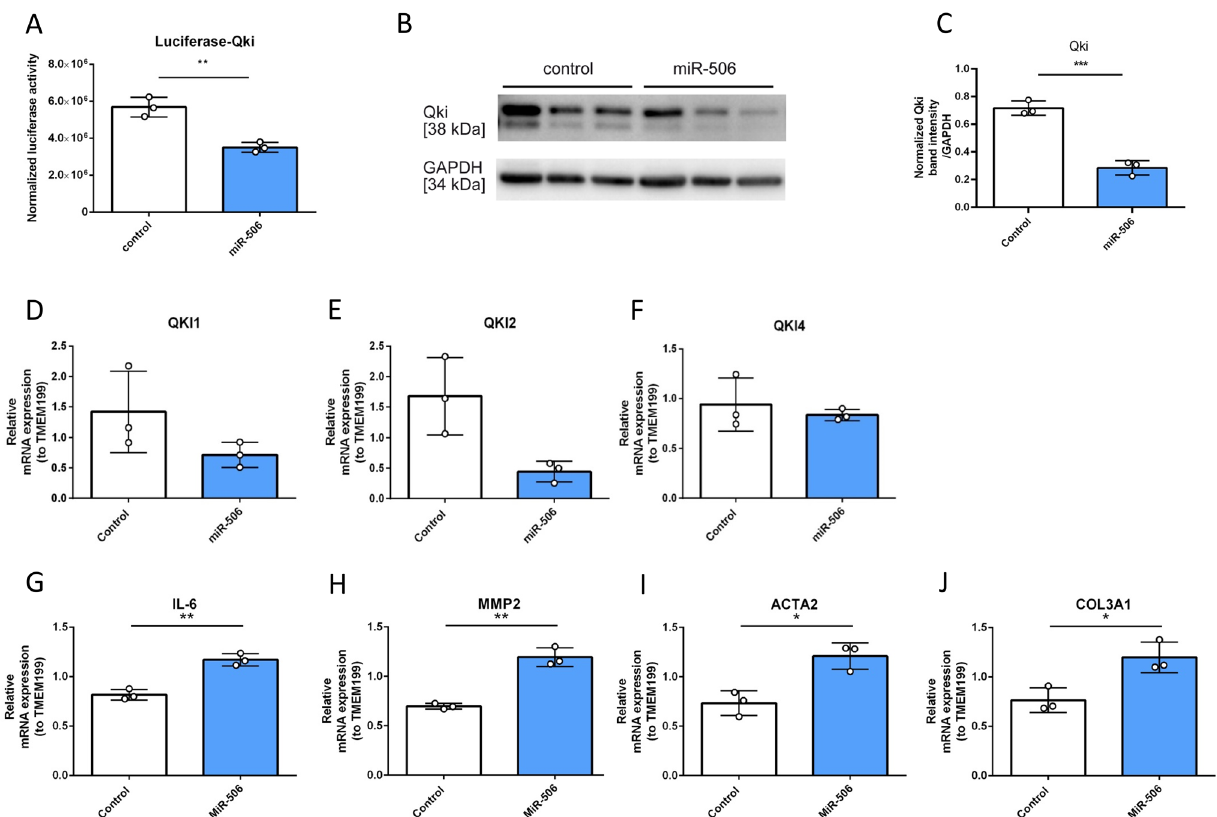
Figure 3. ( A ) Validation of miR-506-3p binding to human QKI 3 ′ -UTR via luciferase assay. (n = 3 experiments). ( B , C ) QKI is downregulated via miR-506 in human lung fibroblasts after 48 h of miR transfection. QKI (exposure 145.708 s) and GAPDH (exposure 36.664 s) detection via Western Blot after 48 h of overexpression (representative Western Blot) in vitro and statistical evaluation. (n = 3 experiments). Gene expression levels of ( D – F ) various QKI mRNA variants and ( G – J ) factors relevant for fibrosis (RT-qPCR) (*p < 0.05, **p < 0.01;